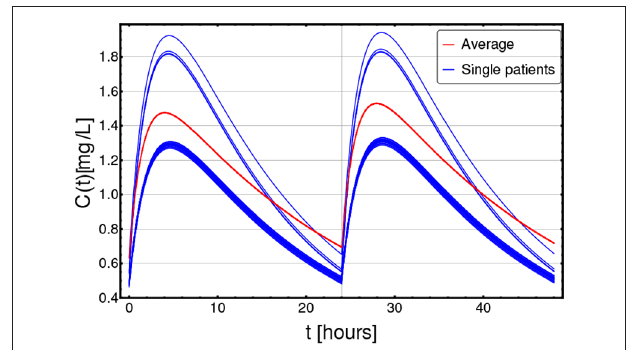
FIGURE 2 | Patient-specific PK models. Personalized pharmacokinetic curves (blue solid lines), as estimated from demographic factors, such as age, sex, and body weight, as per Equations (3) and (4), in the range t ∈ [0,48] h (x axis); y axis describes the drug concentration C ( t ) in [ mg / L ]. The blue curves correspond to the 22 distinct patients included in the dataset, whereas the dashed red curve represents the population-average